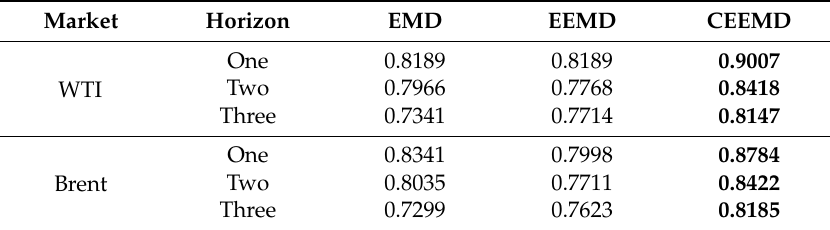
Table 10. The Dstat values of decomposition methods on WTI and Brent crude oil